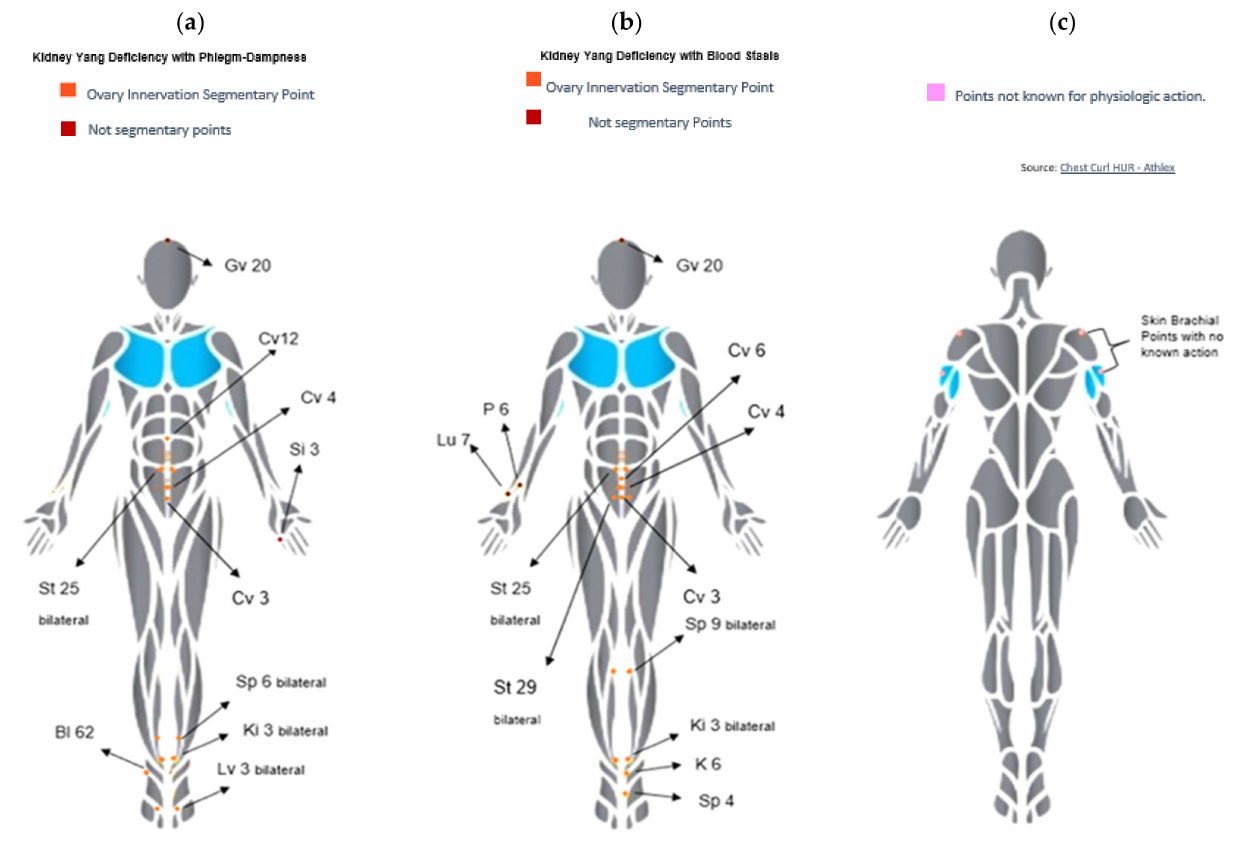
Figure 1. Diagram depiction of the active and sham acupuncture treatments. ( a ) Acupuncture Protocol A; ( b ) Acupuncture Protocol B; ( c ) Sham Acupuncture